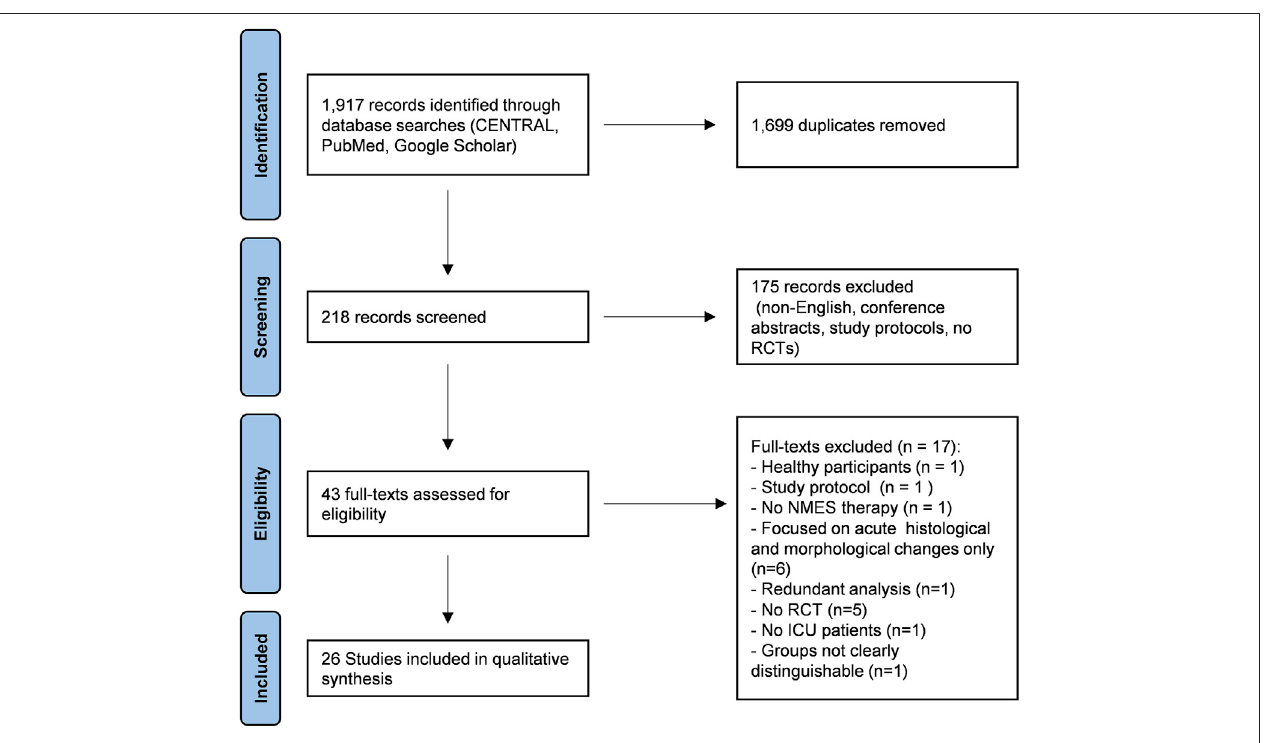
FIGURE1| PRISMA fl owchart.Outof1,917recordsidenti fi edthroughdatabasesearches,43fulltextswereassessedforeligibilityand26studieswereincludedin the qualitative analysis. Eligible articles had to report on electromyostimulation (EMS) or neuromuscular electrical stimulation (NMES) in critically ill patients treated on intensive care unit (ICU) in a randomized controlled trial (RCT) with at least one functional outcome (muscle function, functional independence, weaning